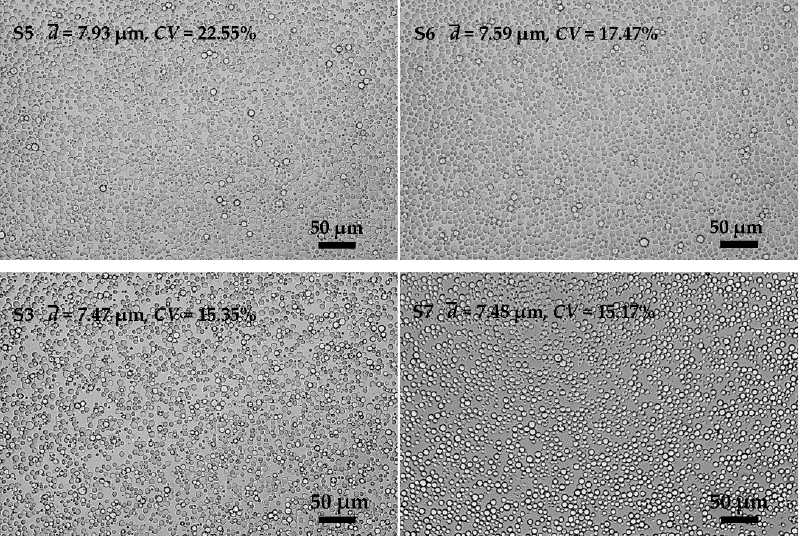
Figure 5. Microscopic photographs of KGM emulsions prepared with different KGM viscosities (KGM I, KGM II, KGM III and KGM IV).